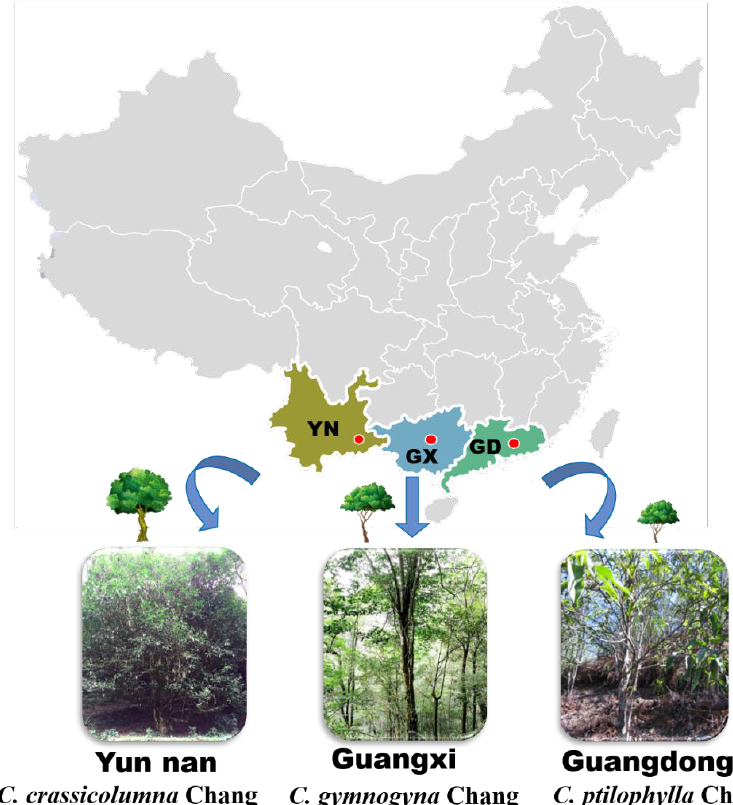
Figure 1. Wild germplasm resources distribution of three Camellia species. Catechins account for about 80% of the total polyphenolic content in tea leaves, and 8–26% of leaf dry weight [15]. A growing number of clinical and epidemiological studies have examined the function of catechins in reducing the risk of hypertension and